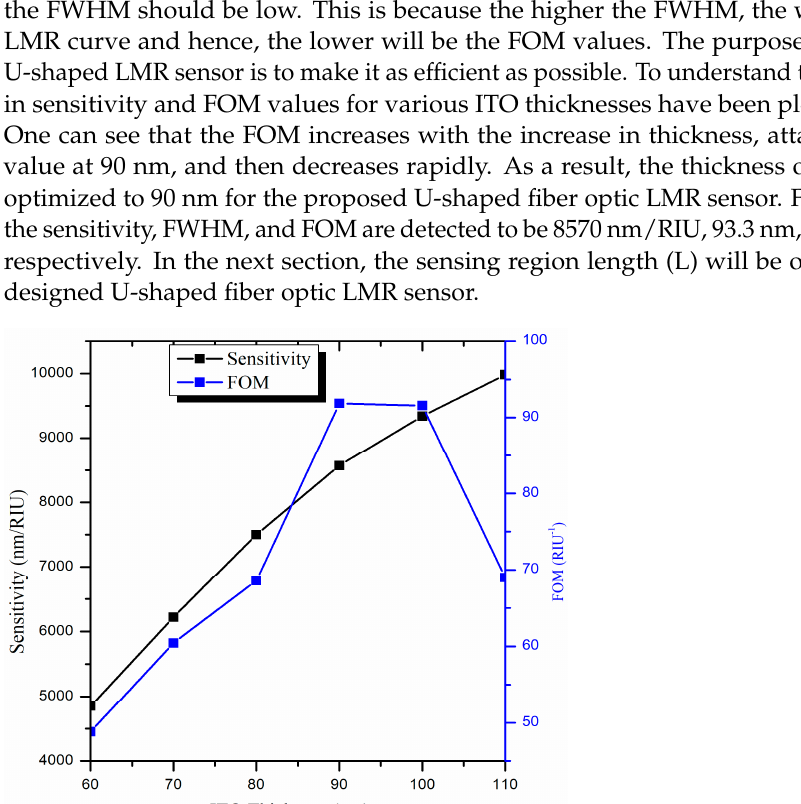
Figure 6. Variation in the sensitivity and figure of merit for various thicknesses of the ITO layer coated over the U-shaped LMR sensing